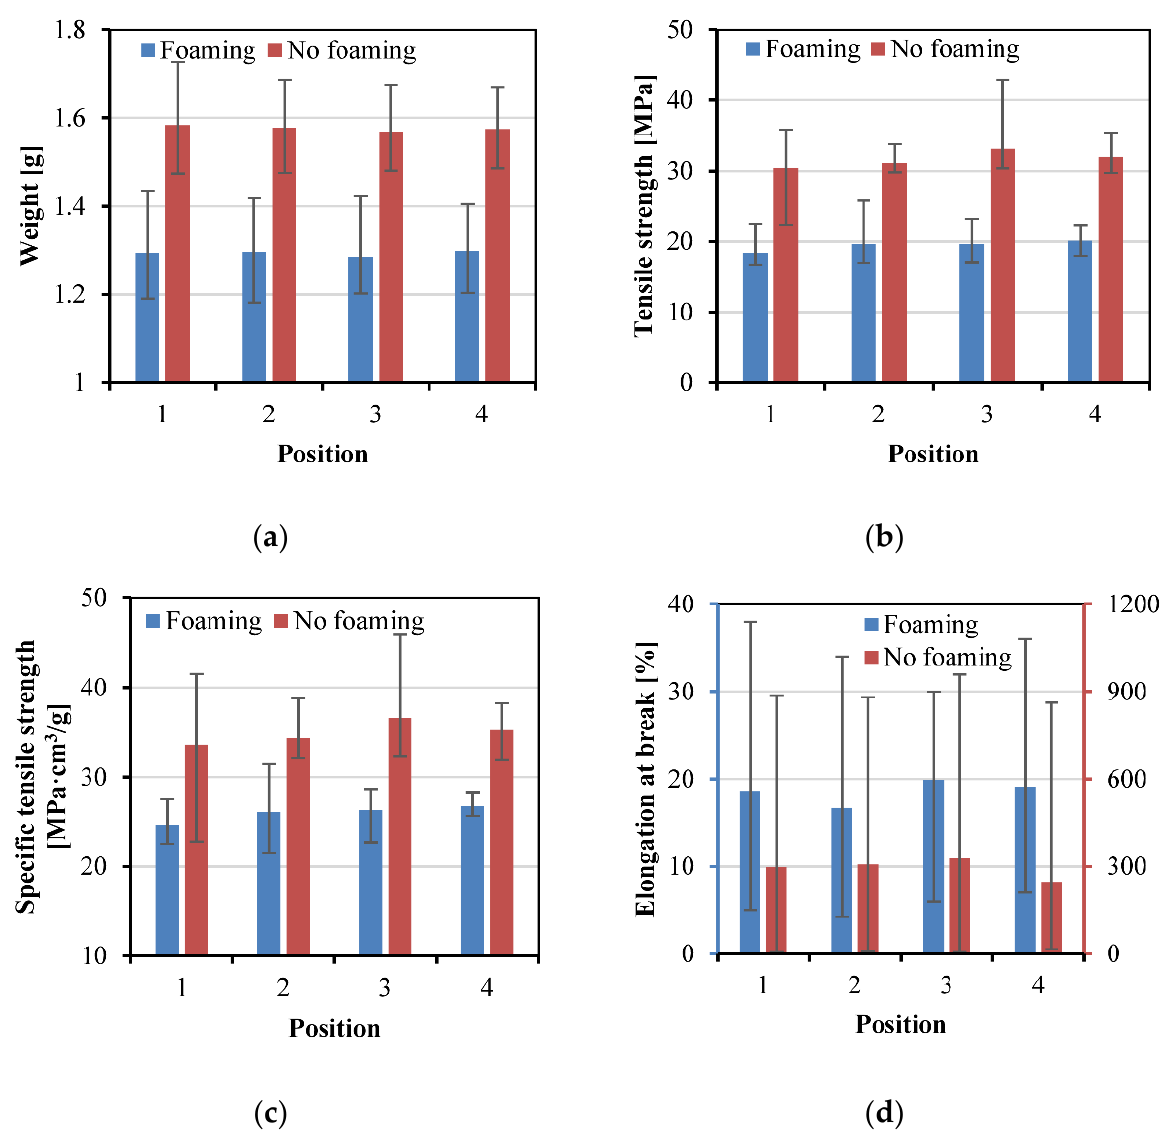
Figure 15. Weight ( a ), tensile strength ( b ), specific tensile strength ( c ), and elongation at break ( d ) of the tensile samples cut from different positions in the disc sample.